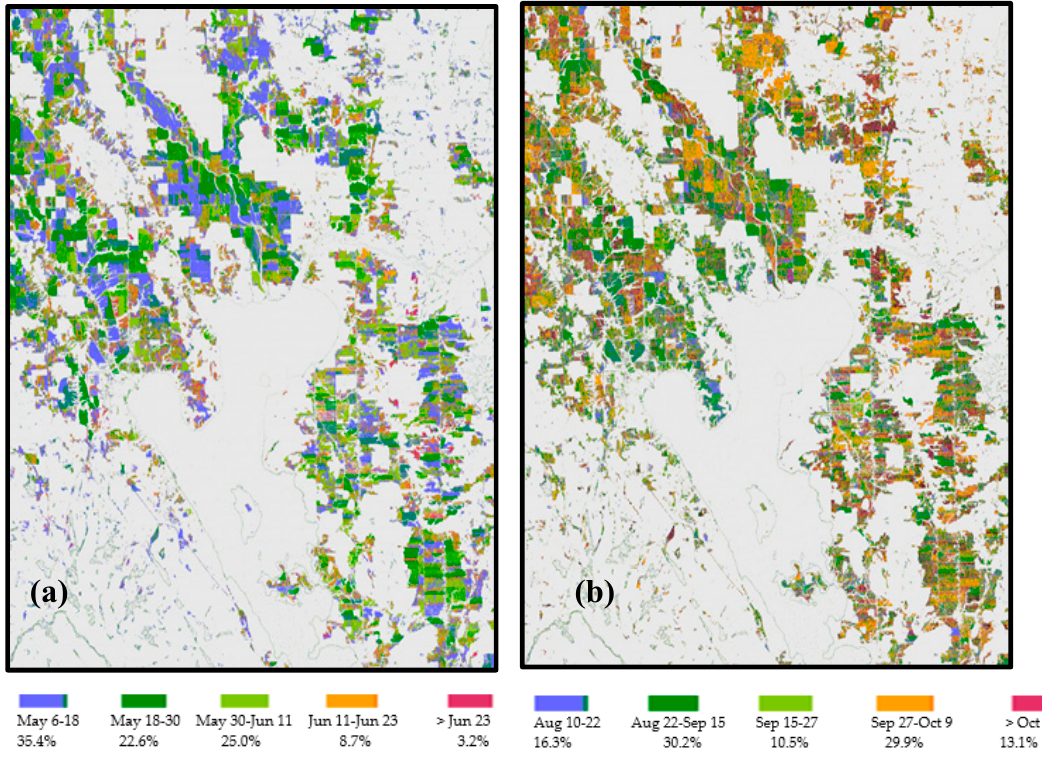
Figure 9. Maps of crop seeding ( a ) and harvest dates ( b ) derived using time-series InSAR coherence and VH backscattering coefficient. Proportion of pixels identified as seeded or harvested for each time.